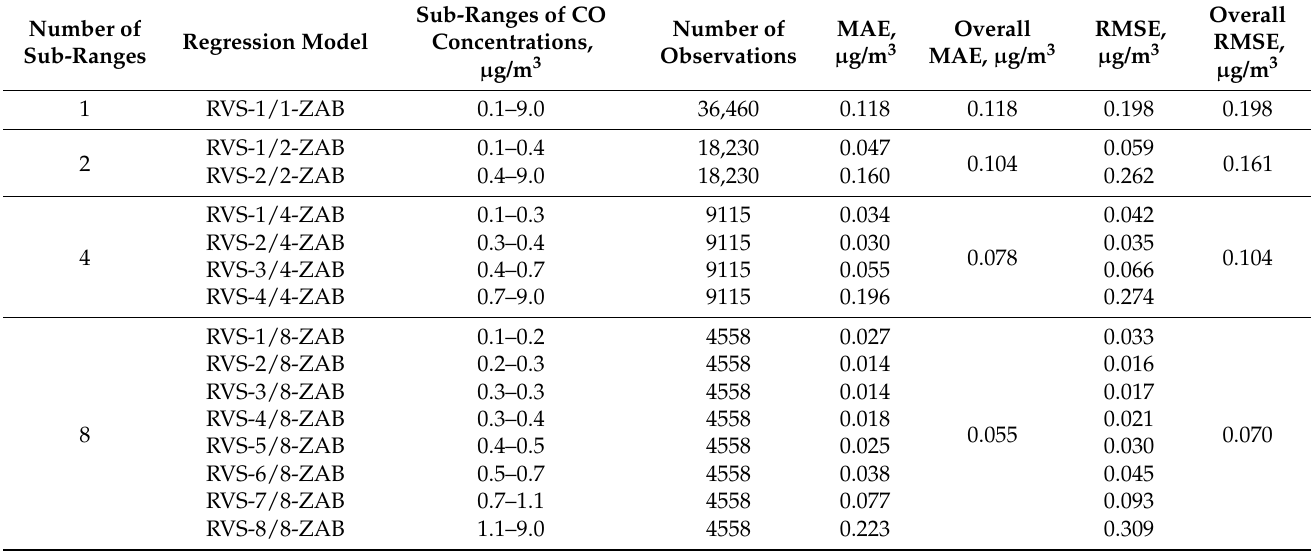
Table 24. Values of approximation errors of CO concentrations in RVS models, Zabrze